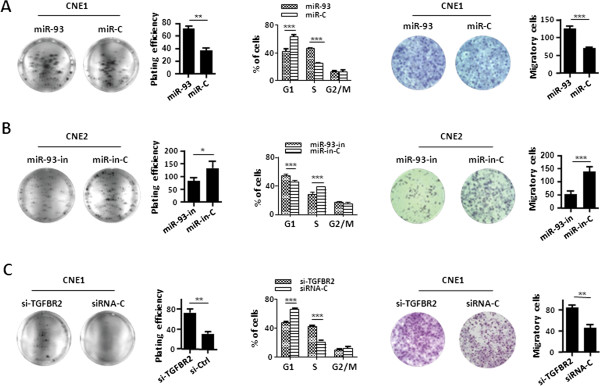
MiR-93-mediated TGFβR2 down-regulation promotes NPC aggressiveness in vitro. (A, C) Representative results of colony formation, cell cycle distribution, and Transwell migration assays in CNE1 cells treated with miR-93 mimic and siRNA-TGFβR2 respectively. Data are presented as mean ± SEM. (Original magnification 200×). (B) Representative results of colony formation, cell cycle distribution, and Transwell migration assays in CNE2 cells treated with miR-93 inhibitor. Data are presented as mean ± SEM. (Original magnification 200×). All results are reproducible in three independent experiments. *P < 0.05, **P < 0.01, ***P < 0.001.